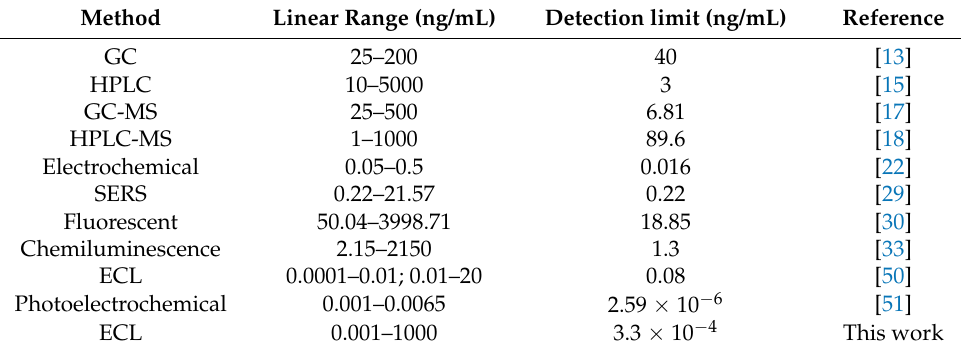
Table 1. Comparison with different methods for detecting ATZ.